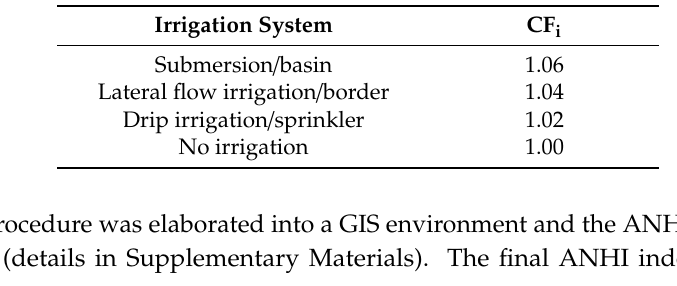
Table 5. Control classes for the irrigation system (CF i